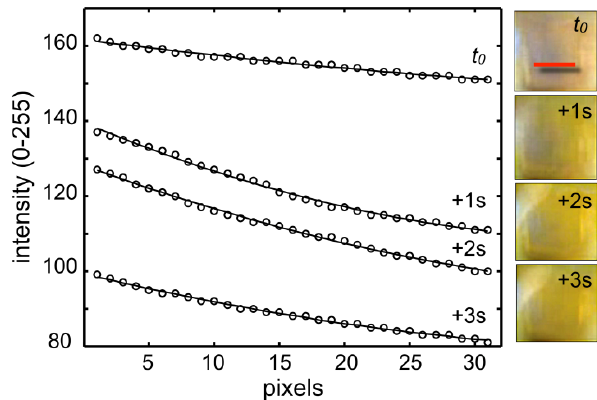
Figure 5. Color changing reaction of resazurine solution from pH7 to pH3 within a microchamber, captured at 15 fps with a Nokia 6720 front camera in video mode and analyzed through the blue camera